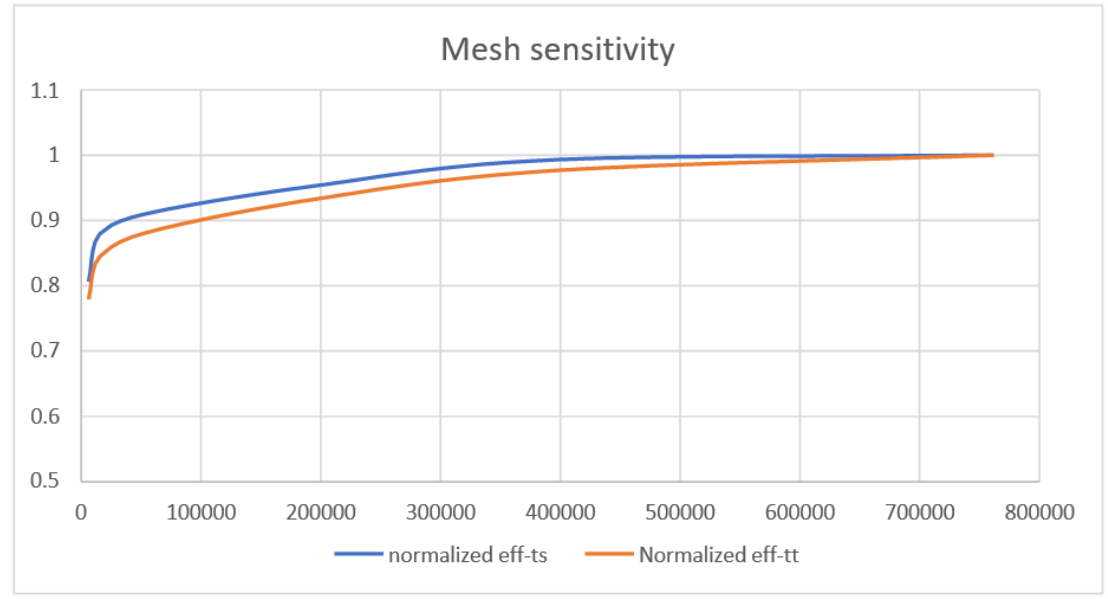
Figure 11. Efficiency results from CFD mesh sensitivity analysis. Figure 11. E ffi ciency results from CFD mesh sensitivity